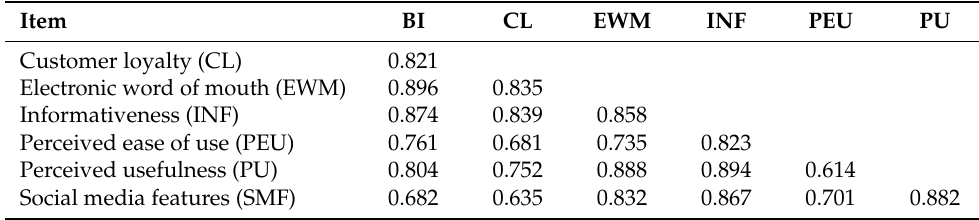
Table 3. Discriminant validity test using the heterotrait–monotrait ratio (HTMT).